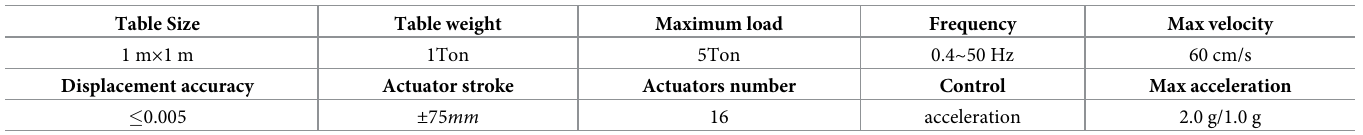
Table 1. Performance indices of the 9-table seismic array. Table Size Table